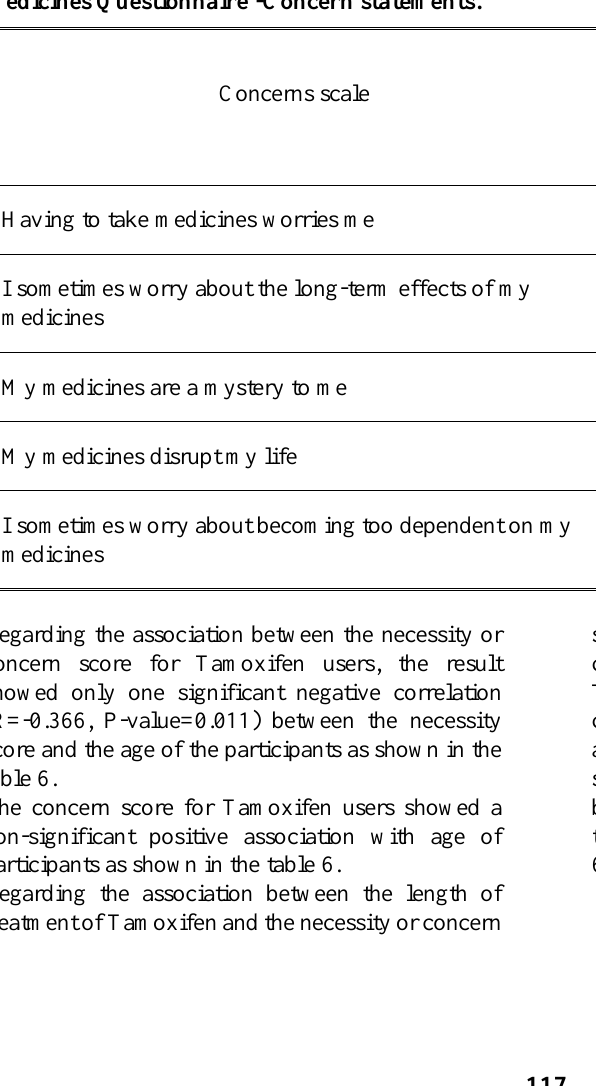
Table 5. Percentages of Tamoxifen and Trastuzumab users agreeing /strongly agreeing with Beliefs about Medicines Questionnaire -Concern